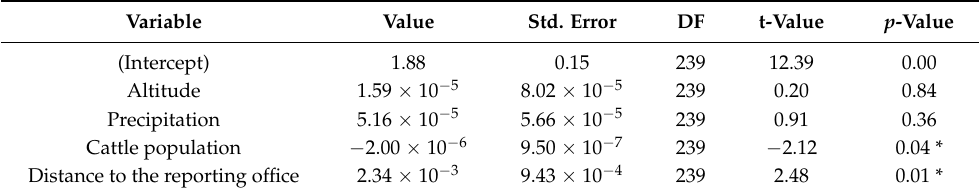
Figure 3. Influence of significant biotic and abiotic conditions on the time of arrival of the first VBR outbreak at each municipality: ( A ) Correlation between the time of the first outbreak (e.g., number of years since 2000) in a municipality and its cattle population. Total livestock population was tested in a different model instead of ‘number of cattle’ without statistical significance (glmmPQL: Estimate = − 1.2 × 10 − 6 , p -value = 0.12). Each point shape represents a biogeographical region; ( B ) Correlation between the time of the first outbreak in a municipality and the geographical distance of that outbreak to the closest reporting office. Lines (blue) represent the tendency estimated for the model and the shadow represents the confidence interval (CI = 95%, grey) estimated using the method ‘lm’ in the geom_smooth function ggplot2 in R. Table 1. Drivers correlated with the time to the first VBR outbreak appearance in each outbreak location: Results from a quasi-Poisson Generalized Linear Mixed Model using a Penalized Quasi- Likelihood with the glmmPQL function in R, including region as a random effect. Time to the first outbreak was not significantly correlated to the total livestock population tested in a different model instead of ‘number of cattle’ (glmmPQL: Estimate = − 1.2 × 10 − 6 , p -value = 0.12). Asterisks identified values considered as statistically significant at p -value <